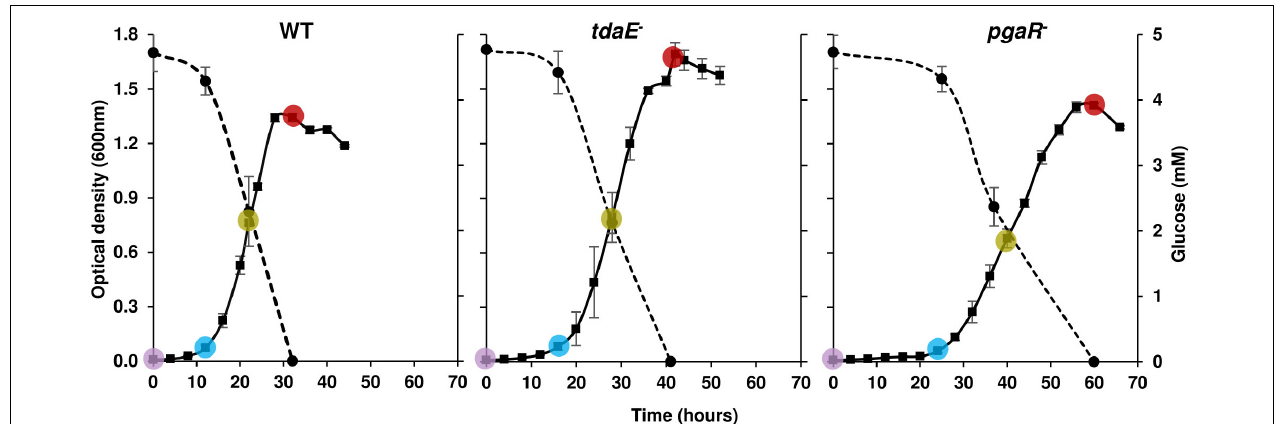
FIGURE 1 | Substrate utilization and growth curves of P. inhibens DSM 17395 wild type (WT), tdaE − mutant and pgaR − mutant based on optical density on the left Y-axis over time on the X-axis. Solid lines correspond to OD 600 (left side Y-axis) and dotted lines to glucose concentration (right side Y-axis). Error bars depict standard deviation of four biological replicates. The colored circles correspond to the sampling time points T 0 (purple), T 1 (blue), T 2 (green) and T 3 (red) for exometabolome analysis of each strain. OD 600 was measured every 3–4